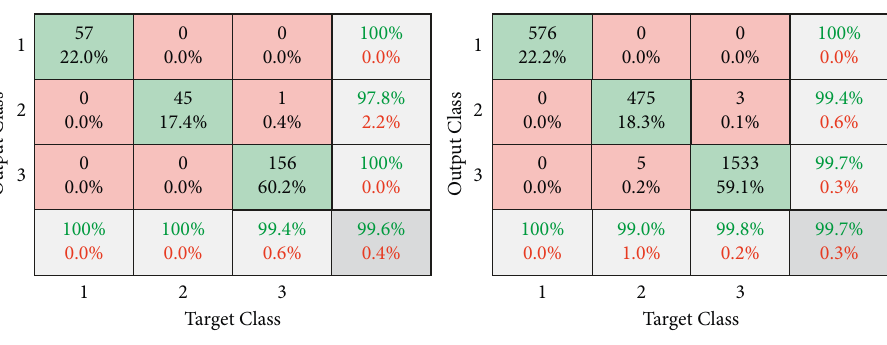
Figure 4: Confusion matrix of classification with